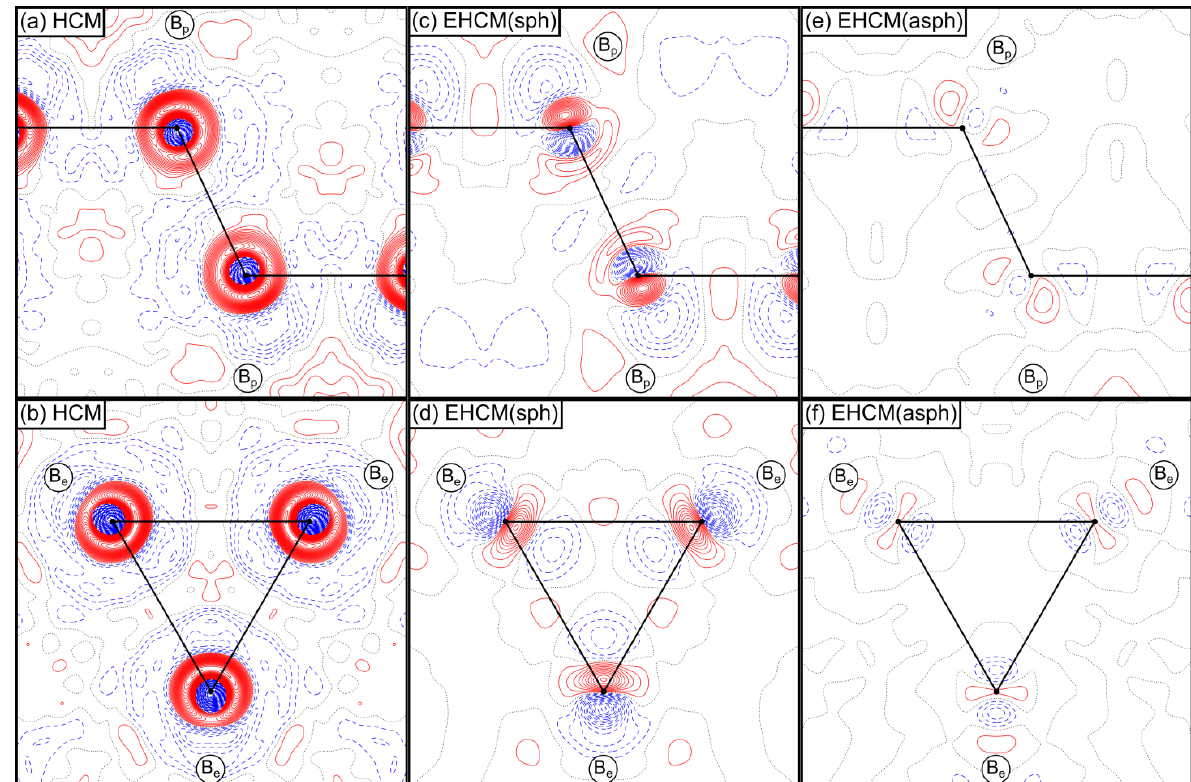
Figure 4. Residual electron density maps of the intericosahedral ( a , c , e ) (2c,2e)-B p -B p bond and ( b , d , f ) (3c,2e)-B e -B e -B e bond in α-boron based on refinements of theoretical static structure factors ( F sta , sin( ϴ )/ λ ≤ 1.6 Å −1 ) employing ( a,b ) an HCM, ( c , d ) an EHCM(sph) and ( e , f ) an EHCM(asph). Positive (solid red) and negative (dashed blue) contour values are shown in 0.01 eÅ −3 steps and the zero contour lines are drawn as dotted black lines.